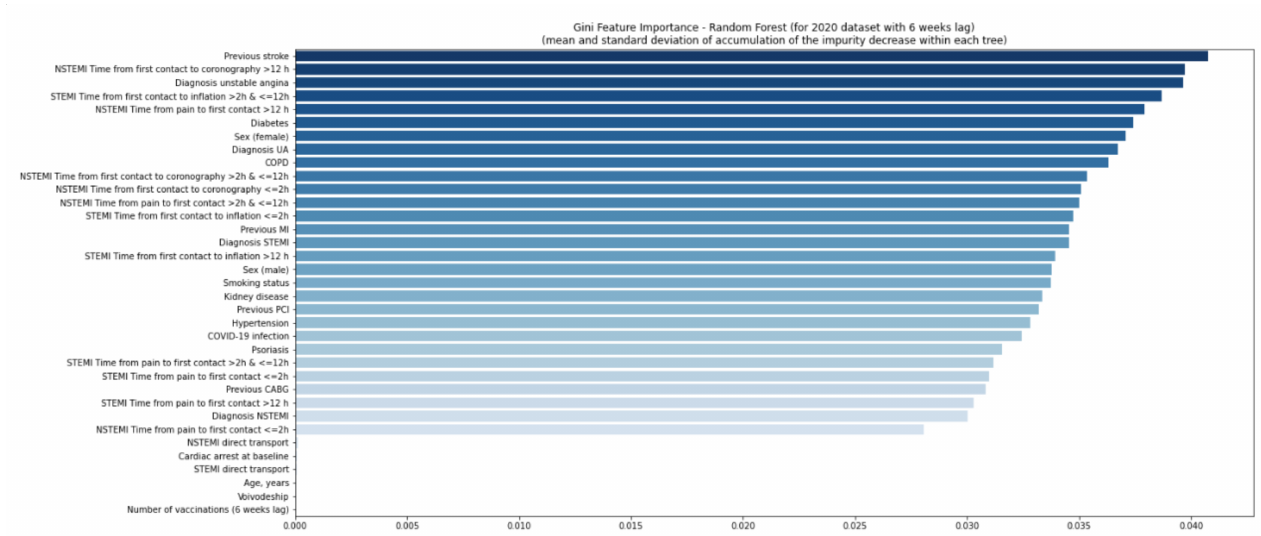
Figure 8. Gini feature importance analysis for patients in 2020 with a six-week lag. The diagram shows the mean decrease of the model’s impurity. In the analysis, each feature’s importance is calculated as the sum over the number of splits across all trees, which includes the feature proportional to the number of samples in the split. In the random forest model, the variable is considered important if the tree split on this variable is affected by large impurity (labels homogeneity in the node) and decrease.